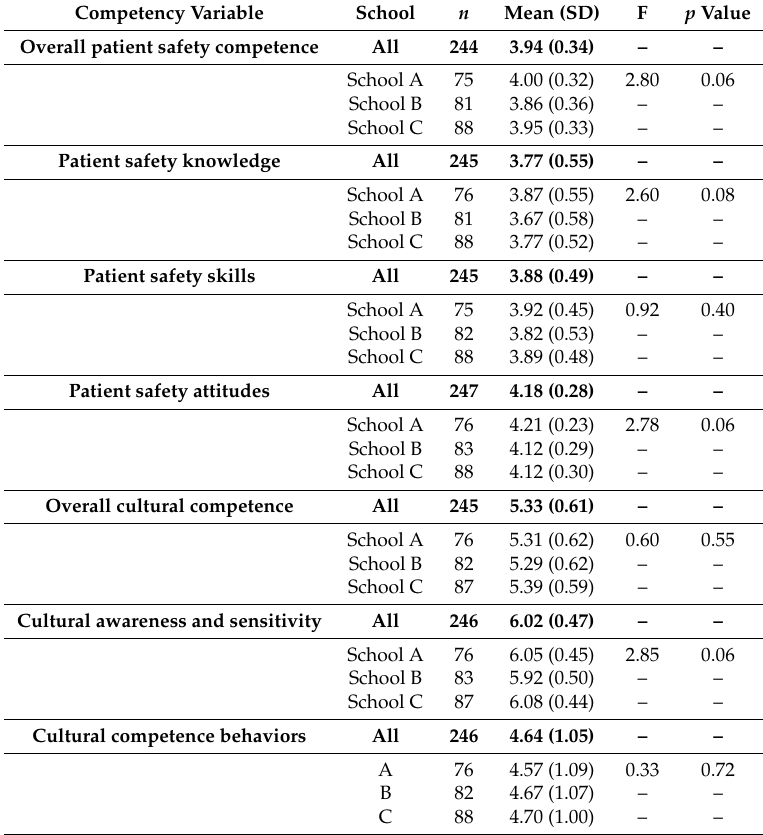
Table 3. Students’ Patient Safety and Cultural Competencies by Nursing